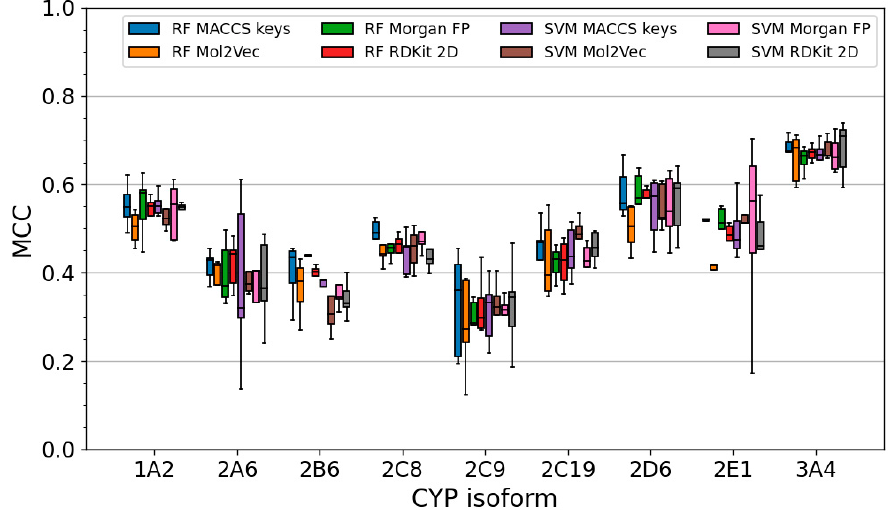
Figure 4. Five-fold CV performance (quantified as Matthews correlation coefficient, MCC) for all classifiers trained on a single type of feature (i.e., MACCS keys, Mol2vec descriptors, Morgan fingerprints, or RDKit 2D descriptors). Whiskers mark the range of the non-outlier data (defined as any data between lower quartile − 1.5 interquartile range and upper quartile +1.5 interquartile range). Table 2. Performance of the best ‐ performing classifiers by MCC built on a single feature set.